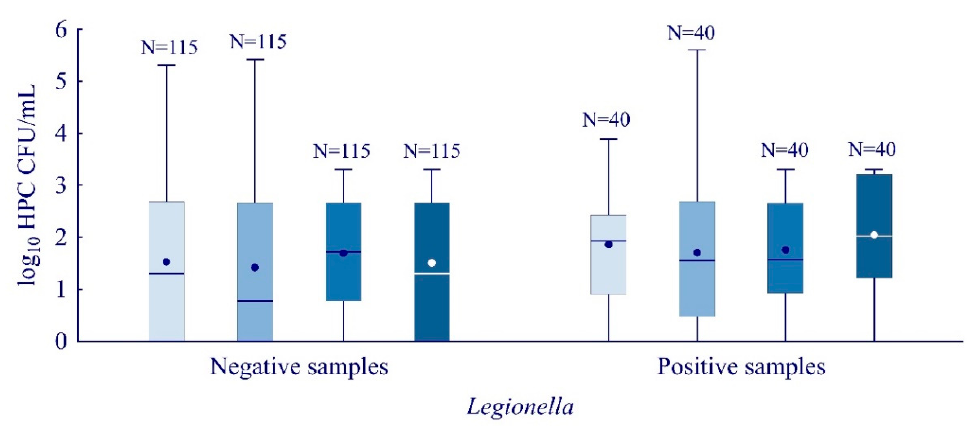
Figure 3. Heterotrophic Plate number (HPC) determined by using different agar and incubation conditions. Boxplots show median (line), mean (point), quartiles (boxes), non-outlier range (whiskers).